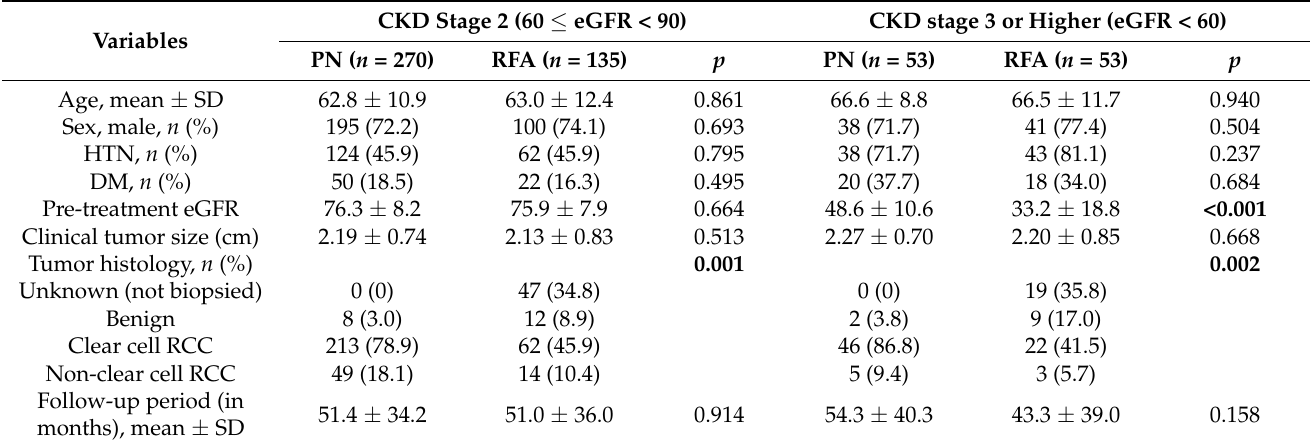
Table 2. Patient demographics and tumor characteristics in propensity score matched cohorts.